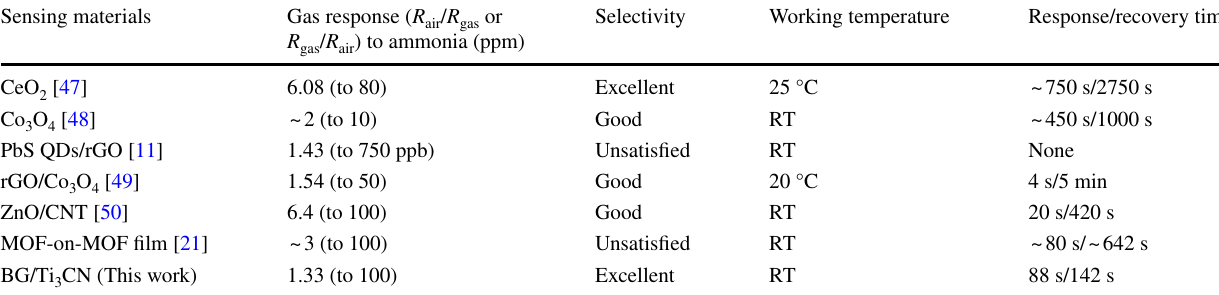
Table 1 Ammonia sensing performance of chemiresistive sensor based on different materials